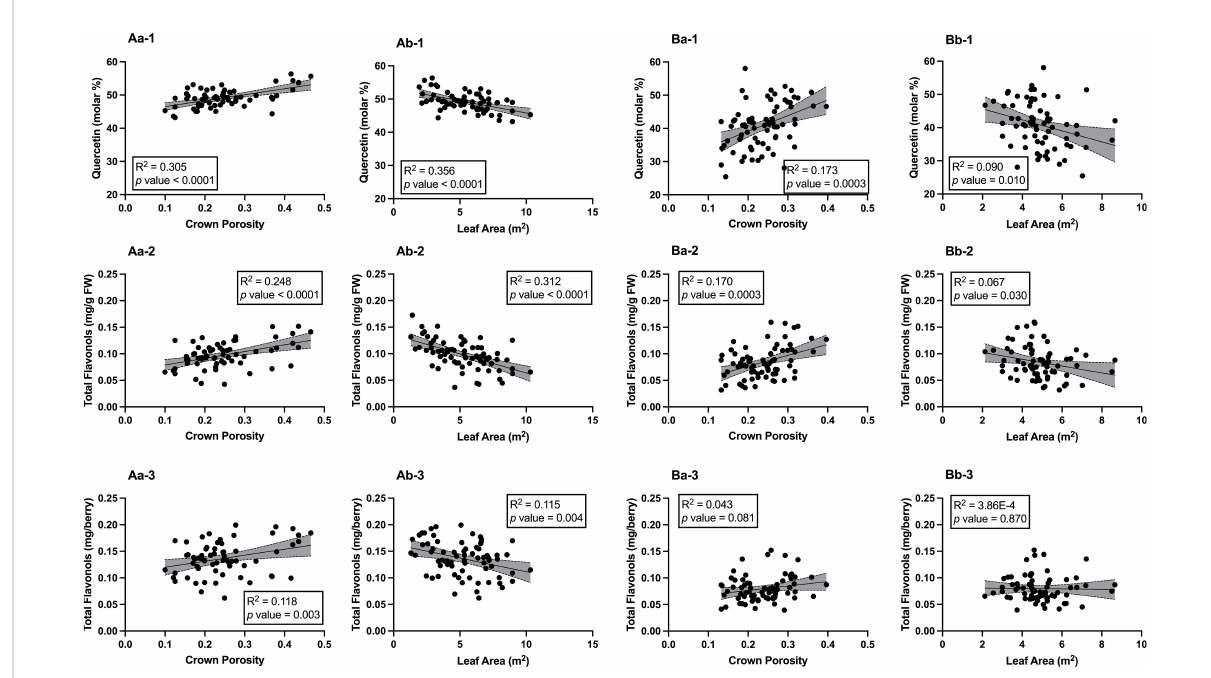
FIGURE 5 Relationships between Canopy Architecture and % molar Quercetin, Total Flavonol Concentration, and Total Flavonol Content in Berry Skins of ‘ Cabernet Sauvignon ’ in Oakville, CA, USA in 2020 (A) 2020 and (B) 2021; (a) correlations with crown porosity, (b) correlations with leaf areas; (1) quercetin (molar %), (2) total fl avonols (mg/g FW), (3) total fl avonols (mg/berry).Grey shade areas indicate 95% con fi dence intervals, and correlation values were expressed in R 2 and p values. FW, berry fresh